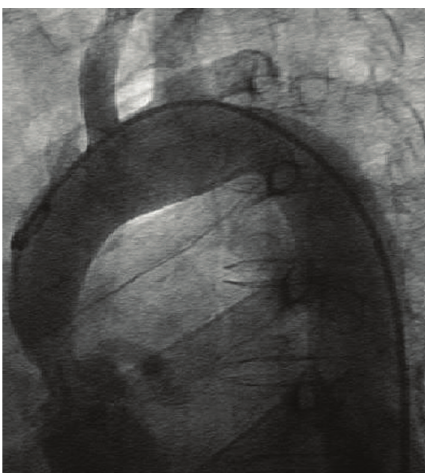
Figure 1: Preoperative angiography.